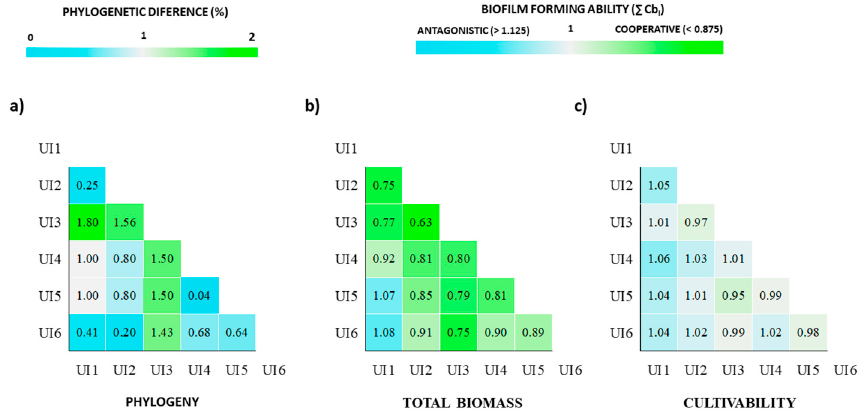
Figure 4. Heat maps showing the phylogenetic differences between the E. coli urinary isolates in percentage ( a ) and their biofilm-forming ability when combined with each other in pairs ( b and c ). Phylogenetic percentages were calculated using the different nucleotides in the 7 housekeeping genes between the six E. coli strains, based in the neighbor-joining method and pairwise distance. The biofilm-forming ability of the combined consortia was scored in terms of total produced biomass ( b ) and cultivability ( c ) according to the ∑ Combinatorial biofilm index ( ∑ Cb I scoring: cooperative (< 0.875), neutral (0.875 < ∑ Cb I < 1.125) and antagonistic (>1.125)] for 0–48 h period of biofilm formation. This analysis on total biomass suggests that both high and low phylogenetic distance between the strains can be accompanied with an increase in the produced biomass, namely, when UI3, the most distant, was paired with all the remaining, as well as when related strains (UI1 with UI2; UI4 with UI5) were combined. All the pairs in terms of cultivability were scored as neutral.